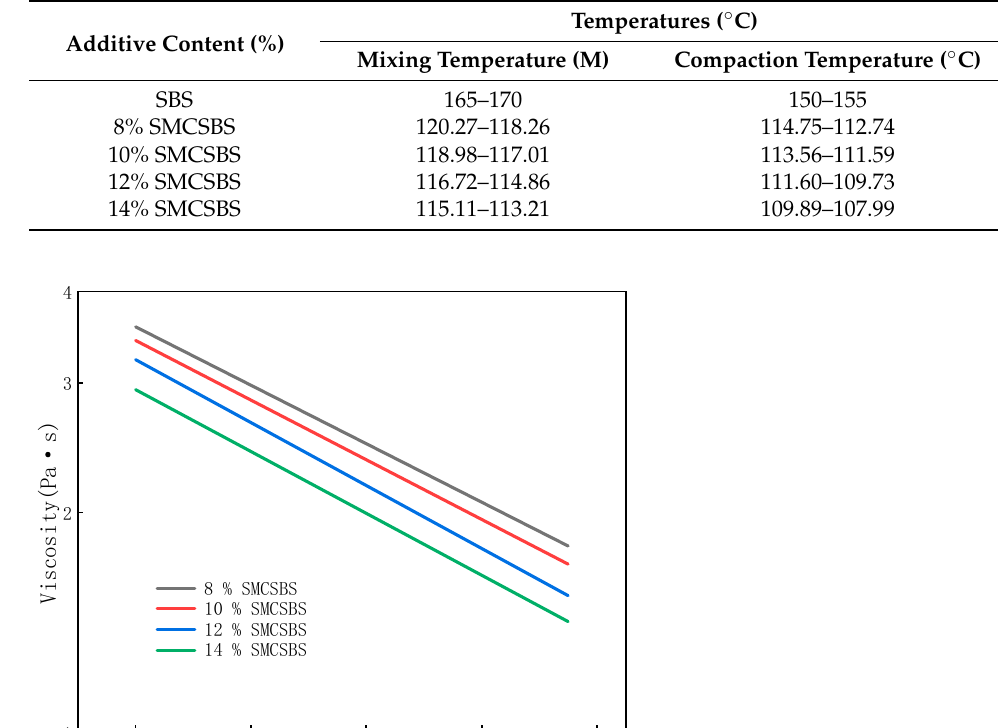
Table 5. Temperature changes (mixing and compaction).